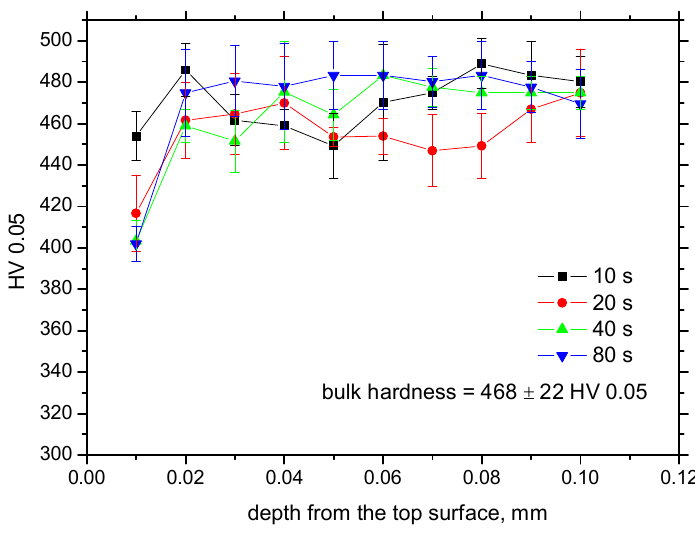
Figure 11. Microhardness profiles.